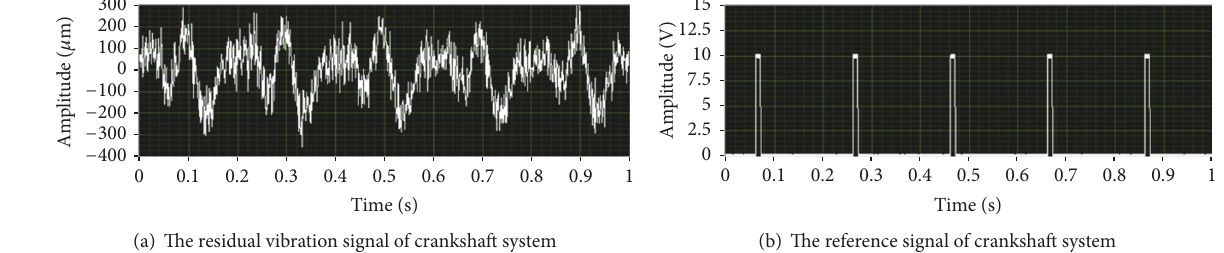
Figure 10: The residual vibration signal and reference signal of crankshaft